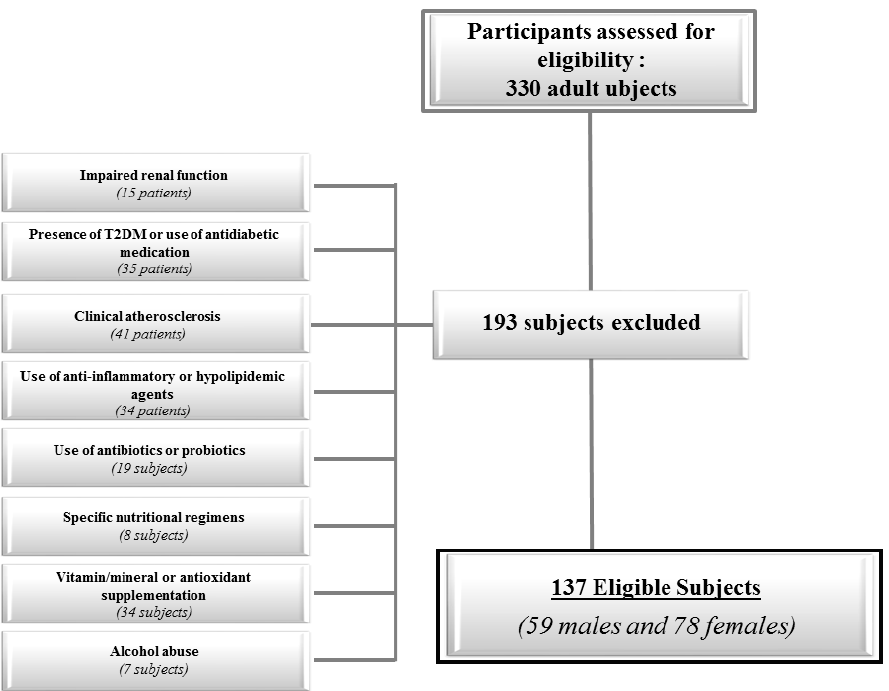
Figure 1. Flow chart of the studied subjects. 143